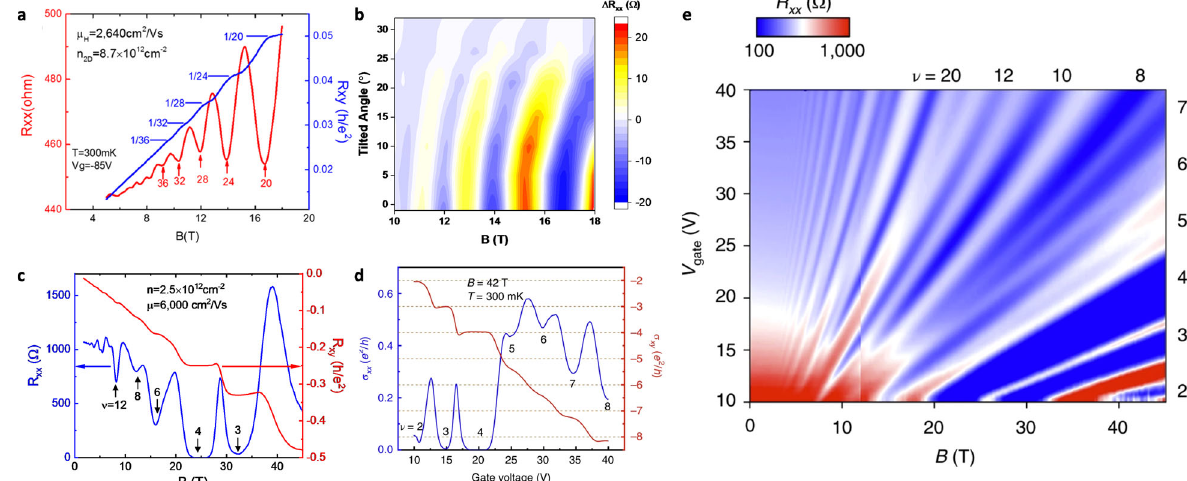
Fig. 4 SdH oscillations and quantum Hall effect in 2D Te. a SdH oscillations in p-type 2D Te with four-fold degeneracy. b Oscillation patterns as a function of B fi eld show 1/cos( θ ) dependence on tilt angle, suggesting the formation of 2D Fermi surface. ( a , b ) are reproduced from ref. 106 . c Magnetic fi eld dependence and ( d ) gate dependence of quantum Hall effect in n-type 2D Te. The 2D electron gas enters the fully quantized regime at fi lling factors of 3 and 4, with all degeneracies being lifted. e Landau fan mapping of SdH and quantum Hall effect in n-type Te in the gate voltage-B fi eld parameter space. ( c – e ) are reproduced from ref. 76